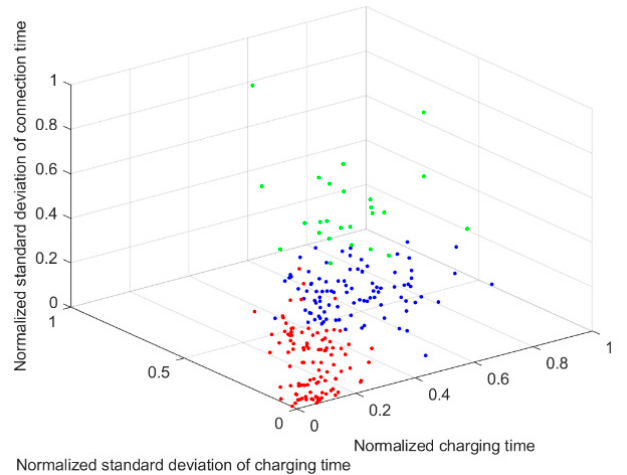
Figure 8. The clustering results under HITL based K-means algorithm.